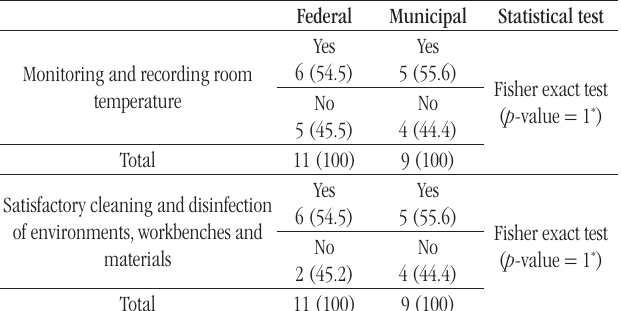
taBLE 4 − Monitoring and recording room temperature, satisfactory cleaning and disinfection of environments, workbenches and materials in municipal and